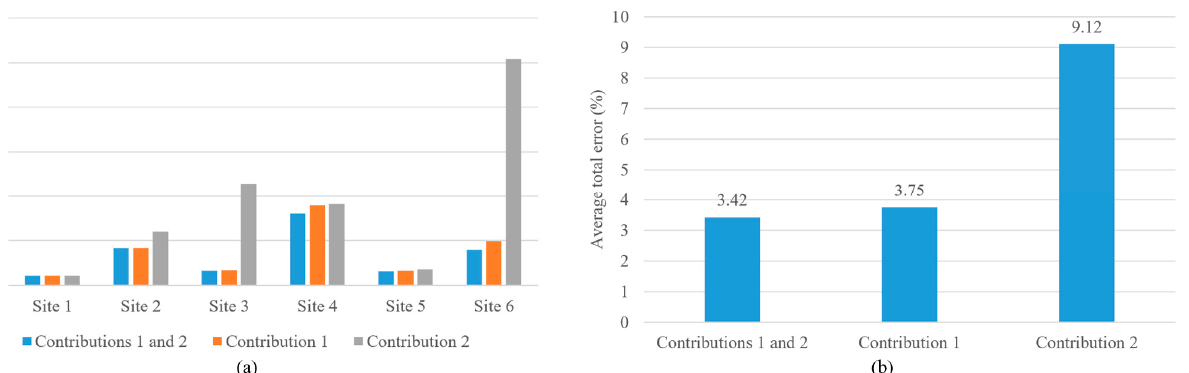
Figure 15. Runtime comparison between the proposed and well-known ground filtering methods in terms of ( a ) each forested site and ( b ) their average values. MSF, PMF, CSF, and PTDF represent the four comparative methods, i.e., maximum slope filtering, progressive morphology filtering, cloth simulation filtering, and progressive triangular irregular network densification filtering methods.